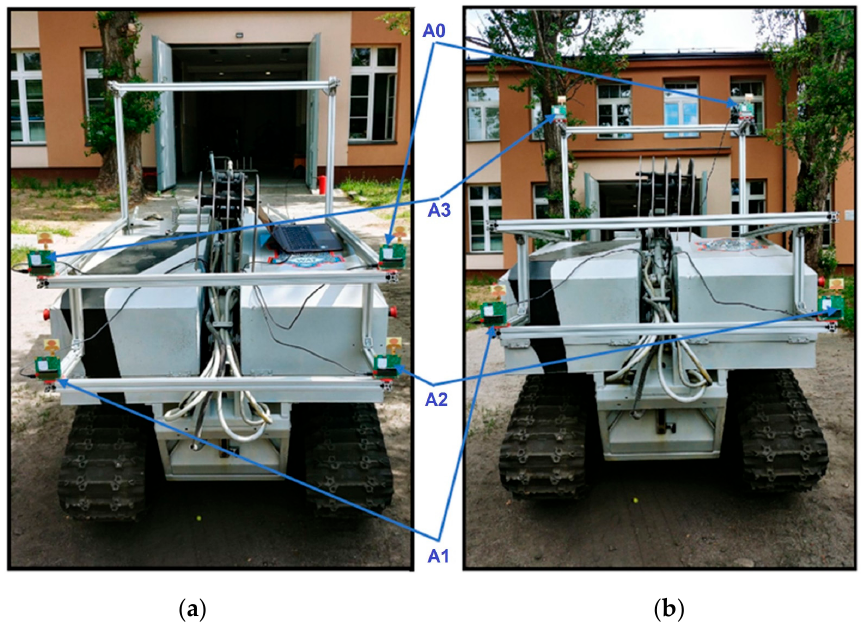
Figure 3. Anchor placement configurations addressed in the following paper. Four anchors present: A0, A1, A2, A3. Two anchor configurations: ( a ) vertical configuration, ( b ) spatial configuration.